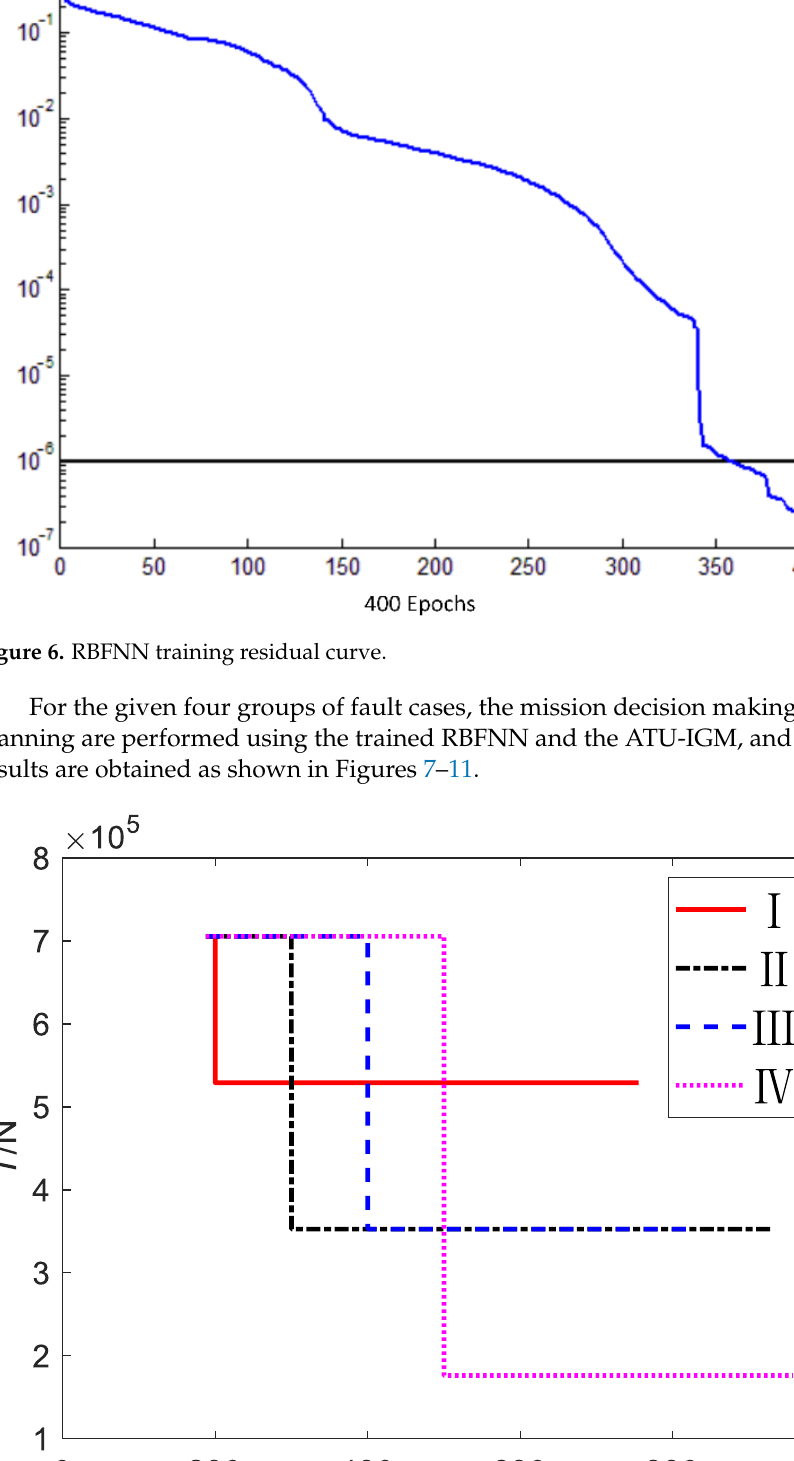
Figure 8. Flight trajectory and terminal orbit.